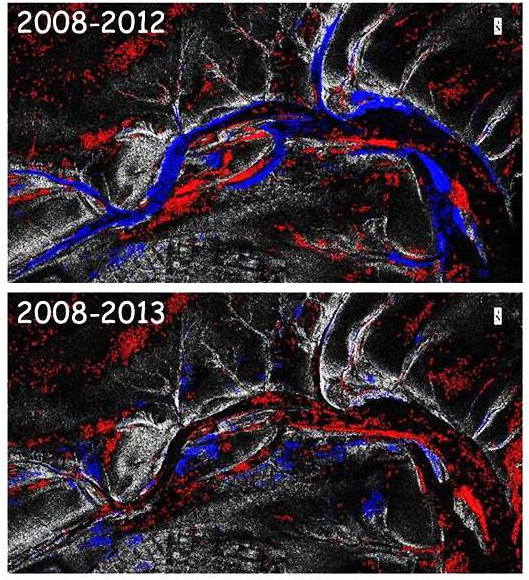
Figure 11. Temporal coefficients derived from the SAR data shown in Figure 10. Red colors denote much higher radar backscatter in the newer image ( TC > 0.8); blue colors denote much higher radar backscatter in the older image ( TC < -0.8) The strong changes detected between 2008 and 2012 (upper panel in Figure 11) along the tidal channel can be attributed to different water levels during the image acquisitions. However, the narrow tidal creek in the lower image center and the sand banks in the tidal channel on the right moved slightly, revealed by blue and red patches at the respective locations in Figure 11 (both panels). In contrast, changes in the radar backscatter from the open flats, in some distance from the tidal creeks and channels, are likely to be due to other factors such as different amounts of remnant water or different soil